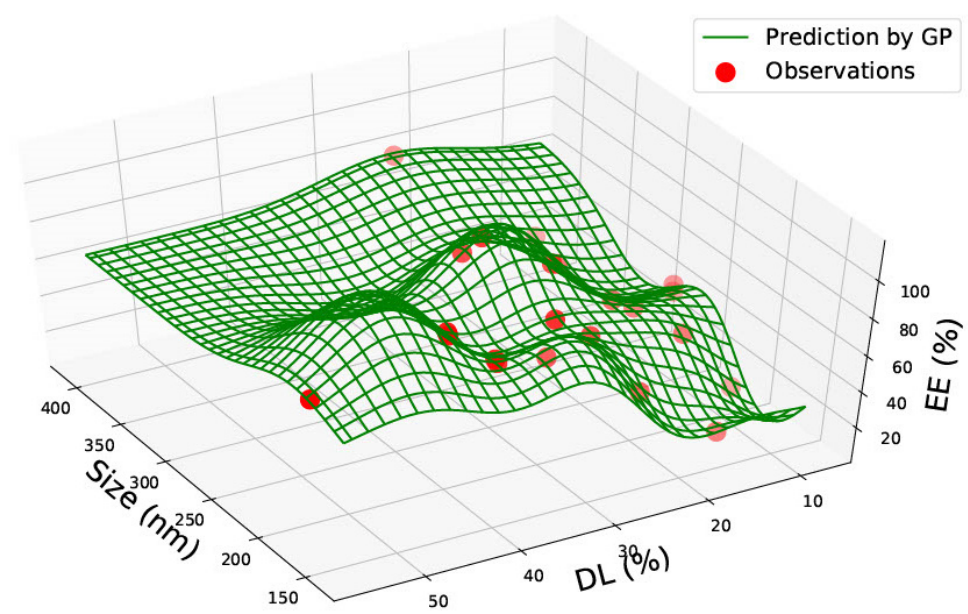
Figure 3. PLGA 50:50—graph showing size (nm), % Drug Load (DL) and Encapsulation Efficiency (EE%).